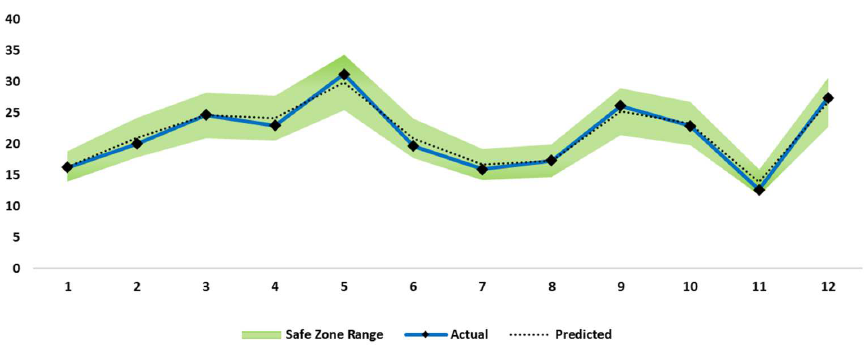
Figure 11. Actual vs. predicted effectiveness.